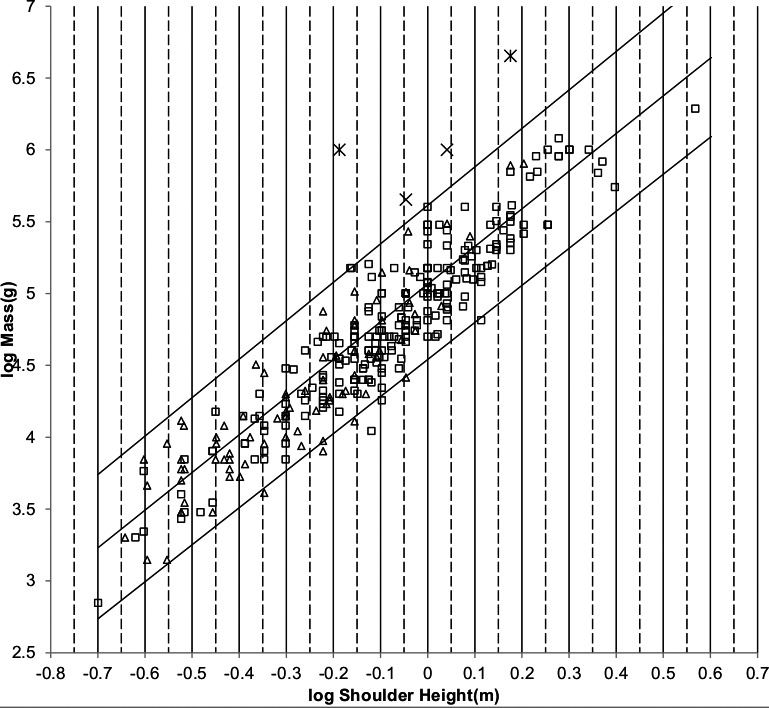
Log body mass as a function of log shoulder height for running/walking Artiodactyla and Carnivora.Data are from Nowak (1999). The upper and lower slanted solid lines are MMLE sturdiness factor boundaries for y = 2/3. The upper boundary was generated with a sturdiness factor, s, of the square root of 3, (3)0.5. The lower boundary was generated with s = (3)−0.5. The middle slanted line was generated with s = 1.0. The slanted lines are for Froude–Strouhal dynamic similarity. The Artiodactyla mass and shoulder height data are marked by open squares. The Carnivora mass and shoulder height data are marked by open triangles. Excluding Hippopatamus amphibus marked by crossed Xes and domestic cattle marked by Xes, \documentclass[12pt]{minimal}
\usepackage{amsmath}
\usepackage{wasysym}
\usepackage{amsfonts}
\usepackage{amssymb}
\usepackage{amsbsy}
\usepackage{upgreek}
\usepackage{mathrsfs}
\setlength{\oddsidemargin}{-69pt}
\begin{document}
}{}${R}_{M}^{2}=0.9997$\end{document}RM2=0.9997. The solid vertical lines demark the AVG method first set of cohorts. The dashed vertical lines demark the second set of cohorts.